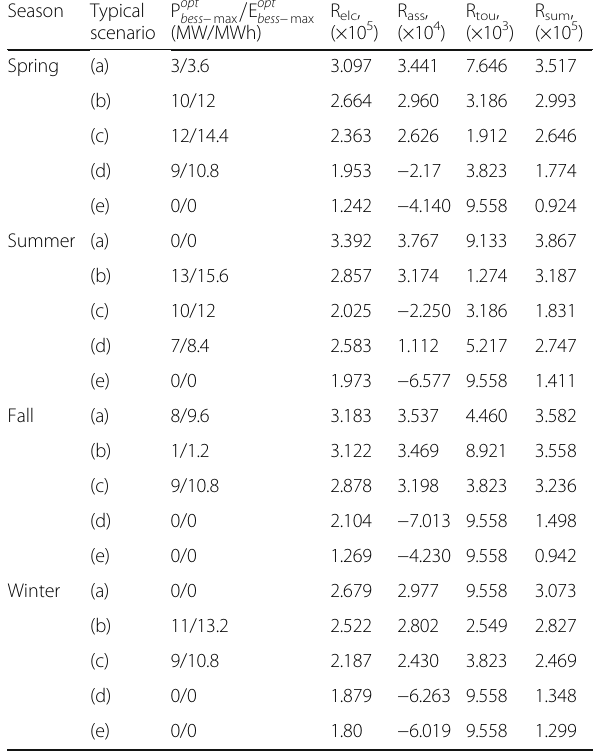
Table 4 The operation modes and expected revenue of the PV-BESS power plant in the typical scenarios Season